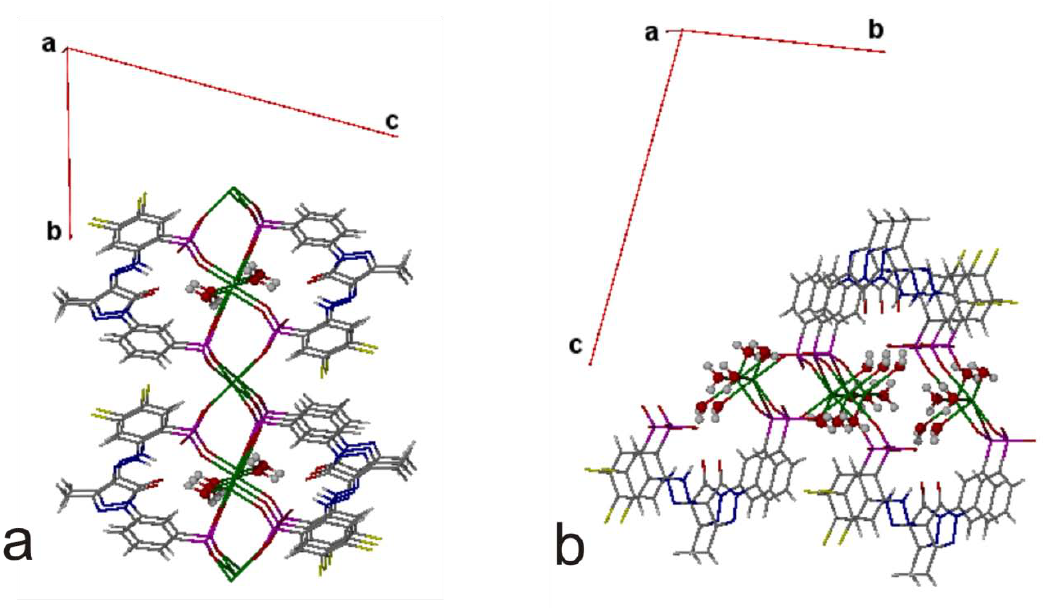
Figure 7. Pigment yellow 183 (a) α form and (b) β form. The green nodes represent Ca 2+ ions